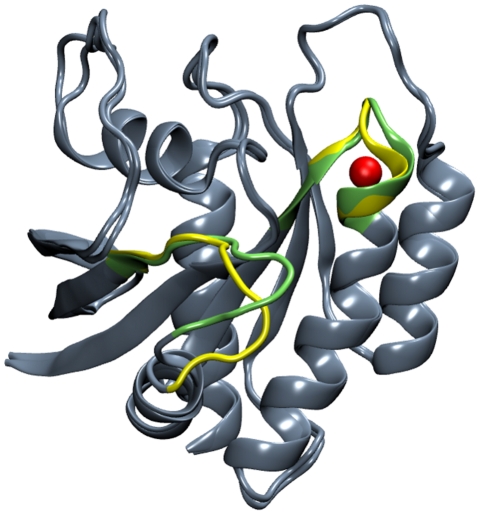
Superimposition of the average structures of conformers with and without W5 (red sphere).Major differences are highlighted in green (with W5) and yellow (without W5), showing allosteric modulation of S2 by W5 located at the N-terminus of H3 across the lobe interface.